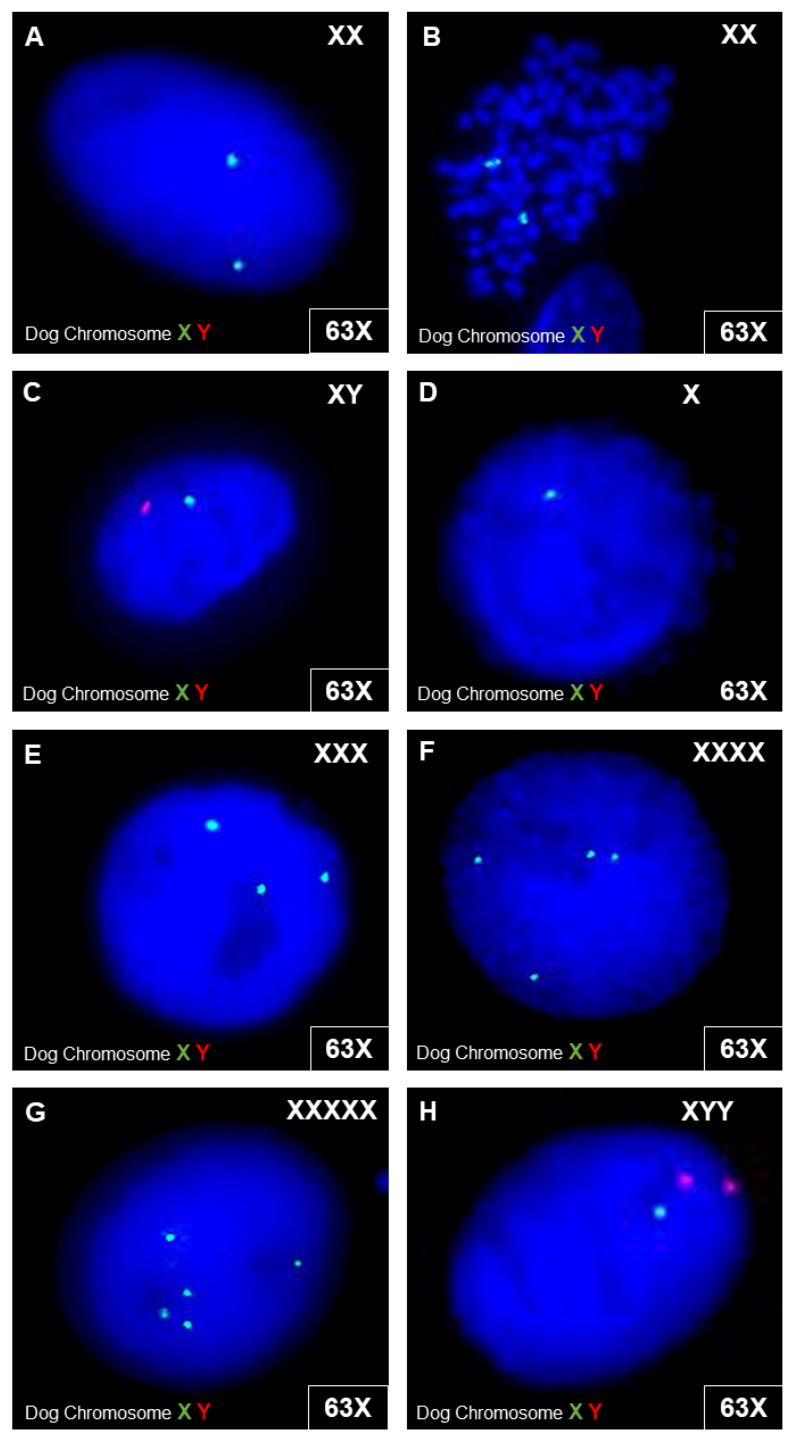
Figure 8. Cytogenetic analyses in canine cells. FISH analyses were performed with dog chromosome XY FISH probes (centromeric alpha satellite DNA probe; chromosome X—spectrum green; chromosome Y—spectrum red) on interphase cells ( A , C – F ) and one metaphase cell ( B ). Exemplary images show the detected signal constellations. In ( A – C ), microscopic images of interphase cells and metaphase cells with a normal gonosomal karyotype are shown. In ( D – H ), examples of interphase cells with different signal patterns are shown , with one signal for X ( D ), three signals for X ( E ), four signals for X ( F ), and five signals for X ( G ). For some interphase cells, a combination of signals from one X-chromosome and two Y-chromosomes were detected ( H ).